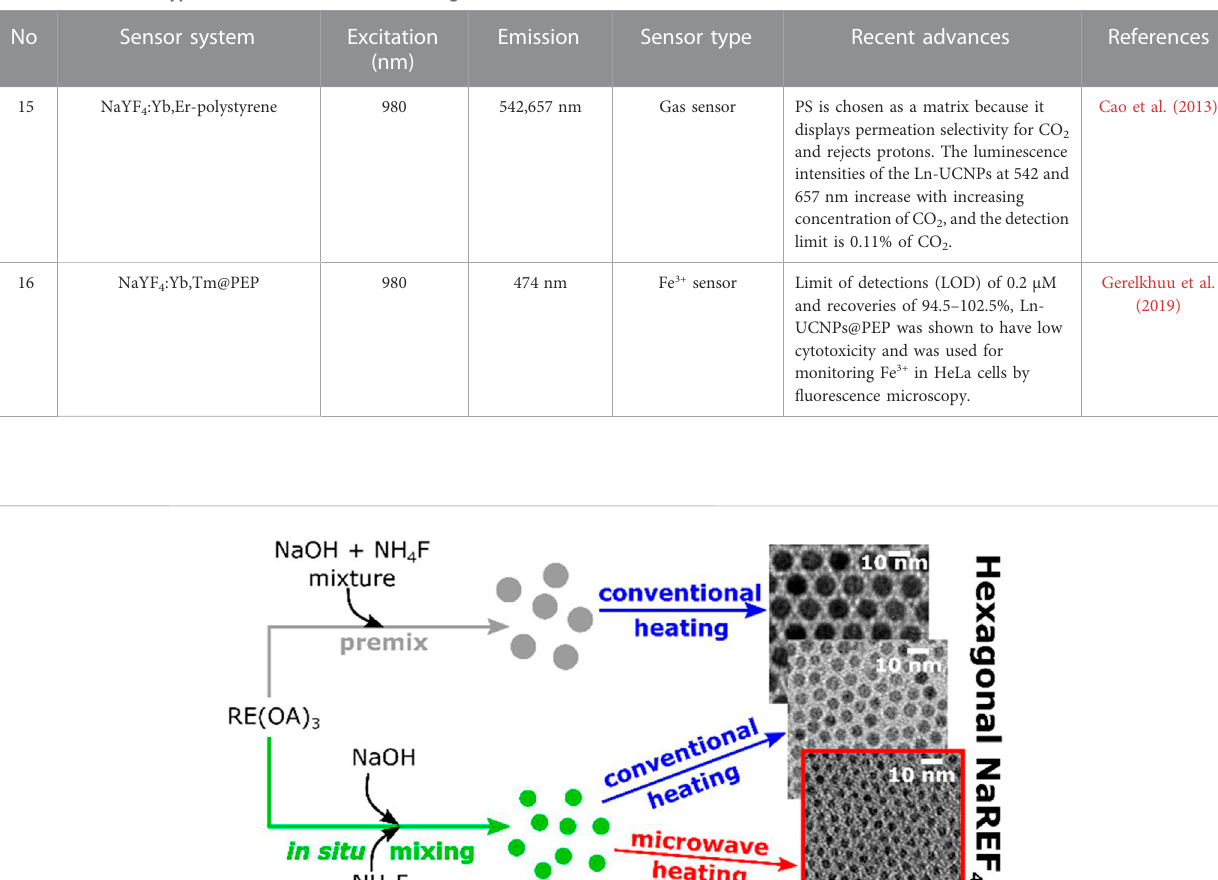
TABLE 2 ( Continued ) Typical cases of Ln-UCNPs for